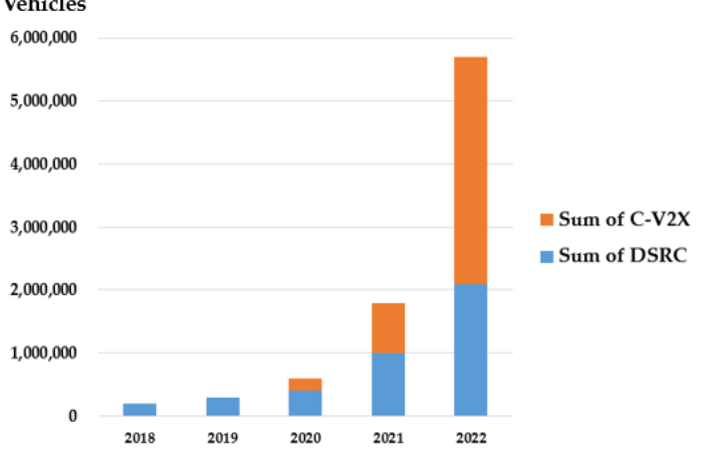
Figure 2. Worldwide forecast for the number of vehicles equipped with V2X technology